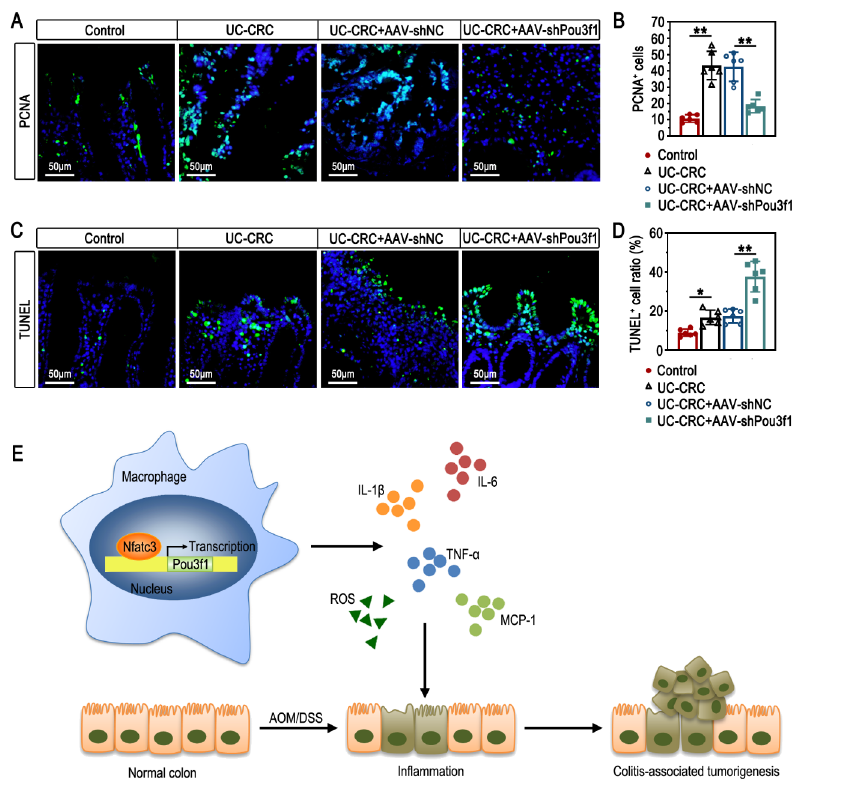
Fig. 7 Pou3f1 knockdown affected cell proliferation and death in colon tumors of UC-CRC mice. (A-B) Representa- tive immunofluorescent images and quantification results of PCNA (green). DAPI (blue) was used to stain the cell nuclei. (C-D) Representative images and quantification results of TUNEL-positive cells (green). DAPI (blue) was used to stain the cell nuclei. (E) The schematic diagram for the regulatory mechanism of Nfatc3-Pou3f1 in the develop- ment of UC-CRC. Data were from n = 6 mice per group. Values were mean ± SD. *, p < 0.05; **, p <